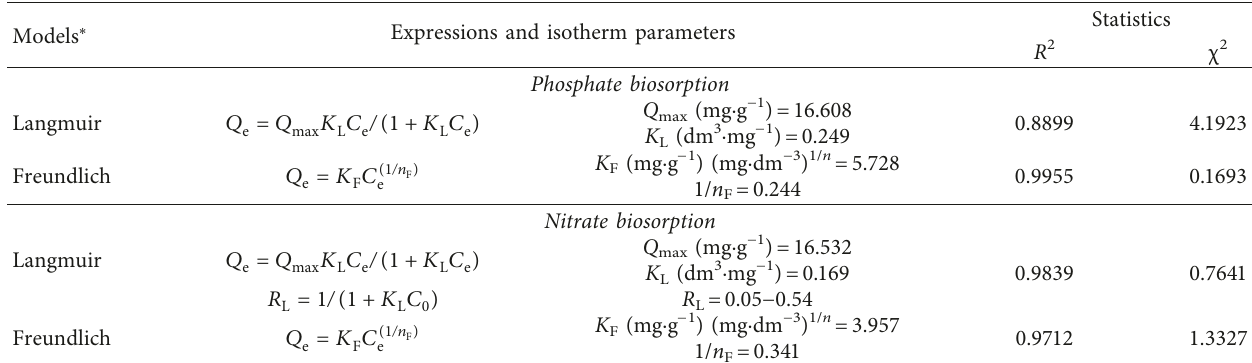
Table 4: Expressions of isotherm models and nonlinear regression parameters for phosphate and nitrate biosorption onto CALV. Models ∗